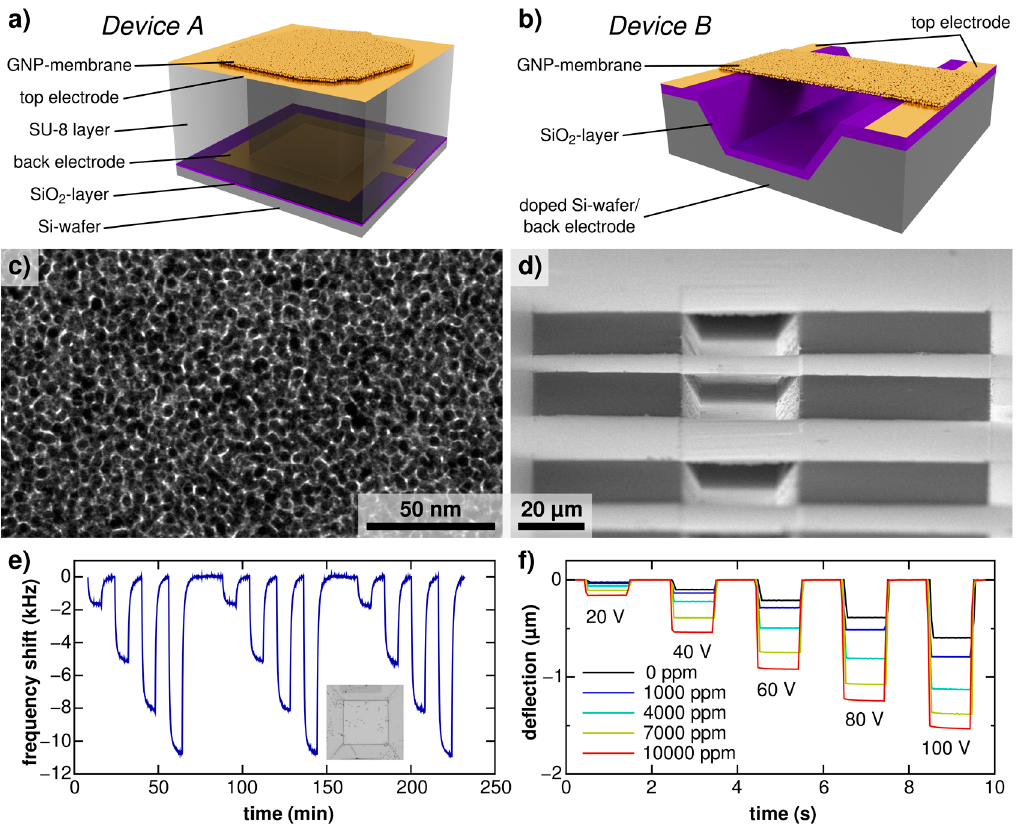
Figure 1. ( a ) Sensor with square cavity defined in an SU-8 resist layer (device A). The cavity is covered by the cross-linked GNP-membrane; ( b ) Sensor having an open bridge structure (device B). The GNP- membrane spans a trench etched into a silicon substrate; ( c ) Representative TEM image of the cross- linked GNP-membrane; ( d ) SEM image of freestanding GNP-membranes spanning a trench etched into a silicon substrate; ( e ) Shifts of the fundamental resonance frequency of sensor device A when dosed with toluene vapor (1000, 4000, 7000, 10,000 ppm) at a total pressure of 20 mbar. Inset: Optical microscopy image of the GNP-membrane. The edge length of the square cavity was ~100 µm; ( f ) Membrane deflections measured when actuating sensor device A by applying DC voltage pulses with and without the presence of toluene vapor, as